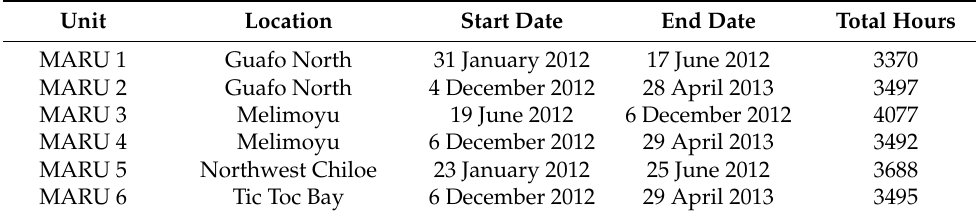
Figure 2. Map of the study area showing the four MARU deployment locations: 1. Northwest Chiloe, 2. Guafo North, 3. Tic Toc Bay, 4. Melimoyu. Table 1. MARU deployment details: location, start and end date and total hours of recordings.